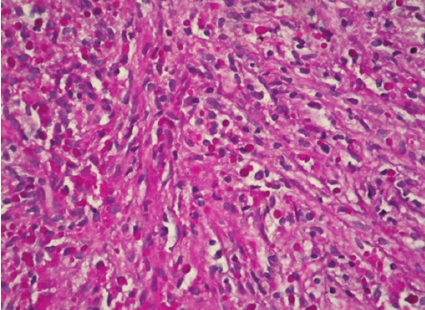
Figure 2: PAS positive Michaelis Gutmann bodies (PAS × 200).